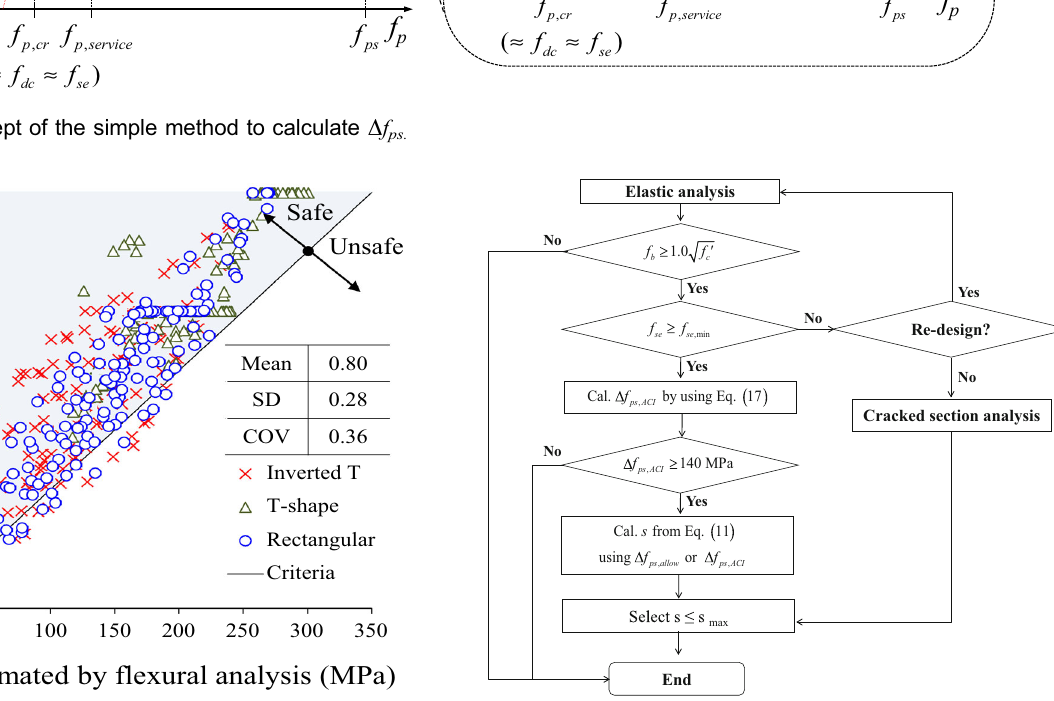
Fig. 16 Determination procedure for the maximum spacing of flexural reinforcement ( s max